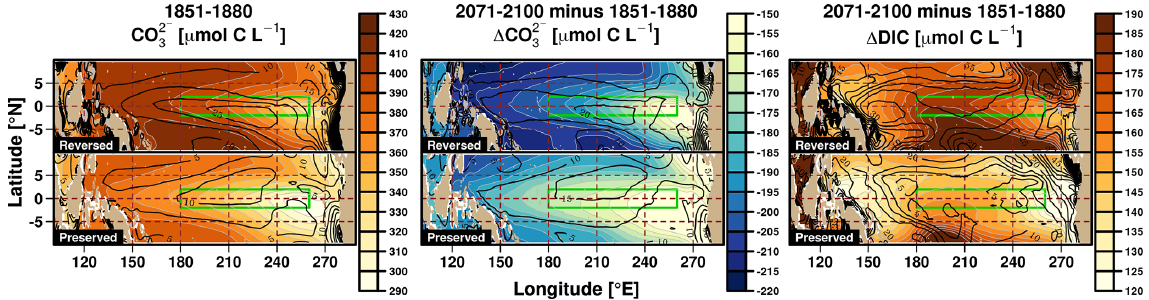
− concentration (µmolCL − 1 ) for the reversed and preserved ESMs for the 1851–1880 period are Figure 10. Maps of average surface CO 2 3 given in the left panel. The middle panel shows the carbonate ion concentration difference between the 2071–2100 and 1851–1880 periods. The right panel shows the surface DIC concentration difference between the 2071–2100 and 1851–1880 periods. The green boxes outline the EP region.